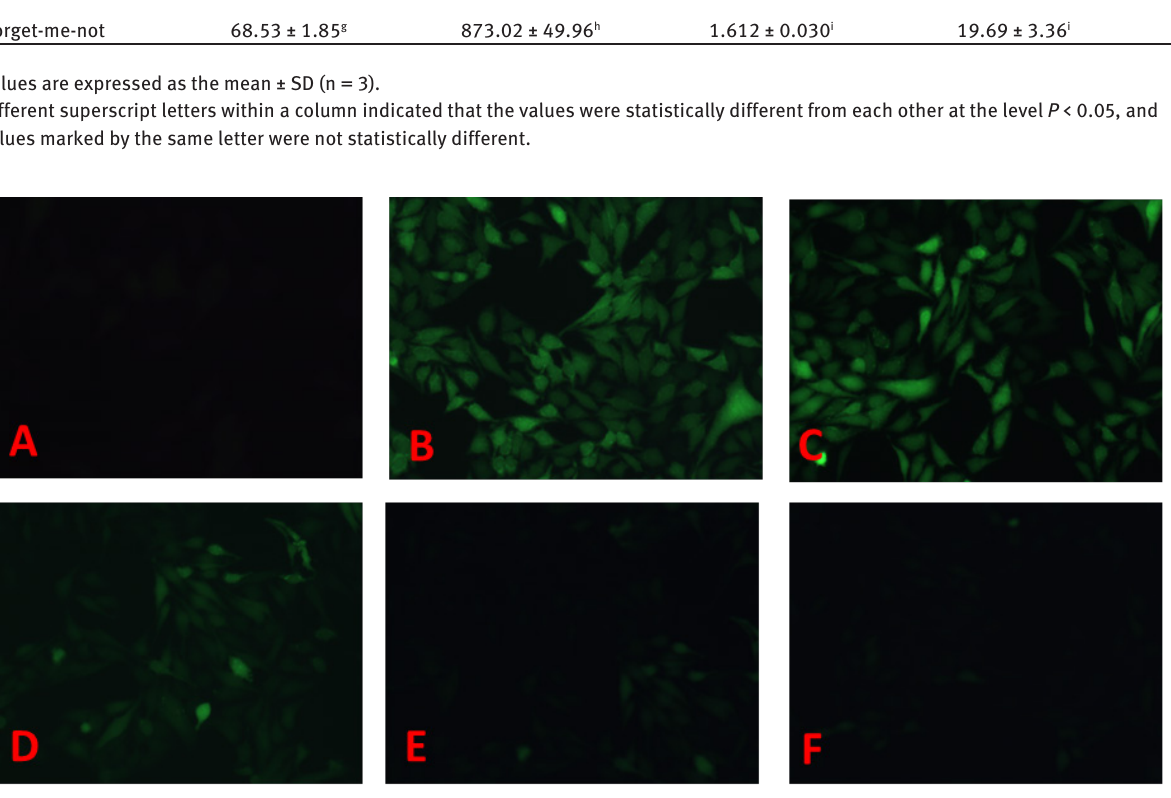
Figure 1: Comparison of ROS in HepG2 cells with DCFH-DA fluorescence staining (A: control group; B: model group; C~F: 5, 10, 25, 50 μg/mL extracts of rosae rugosae flos; ×